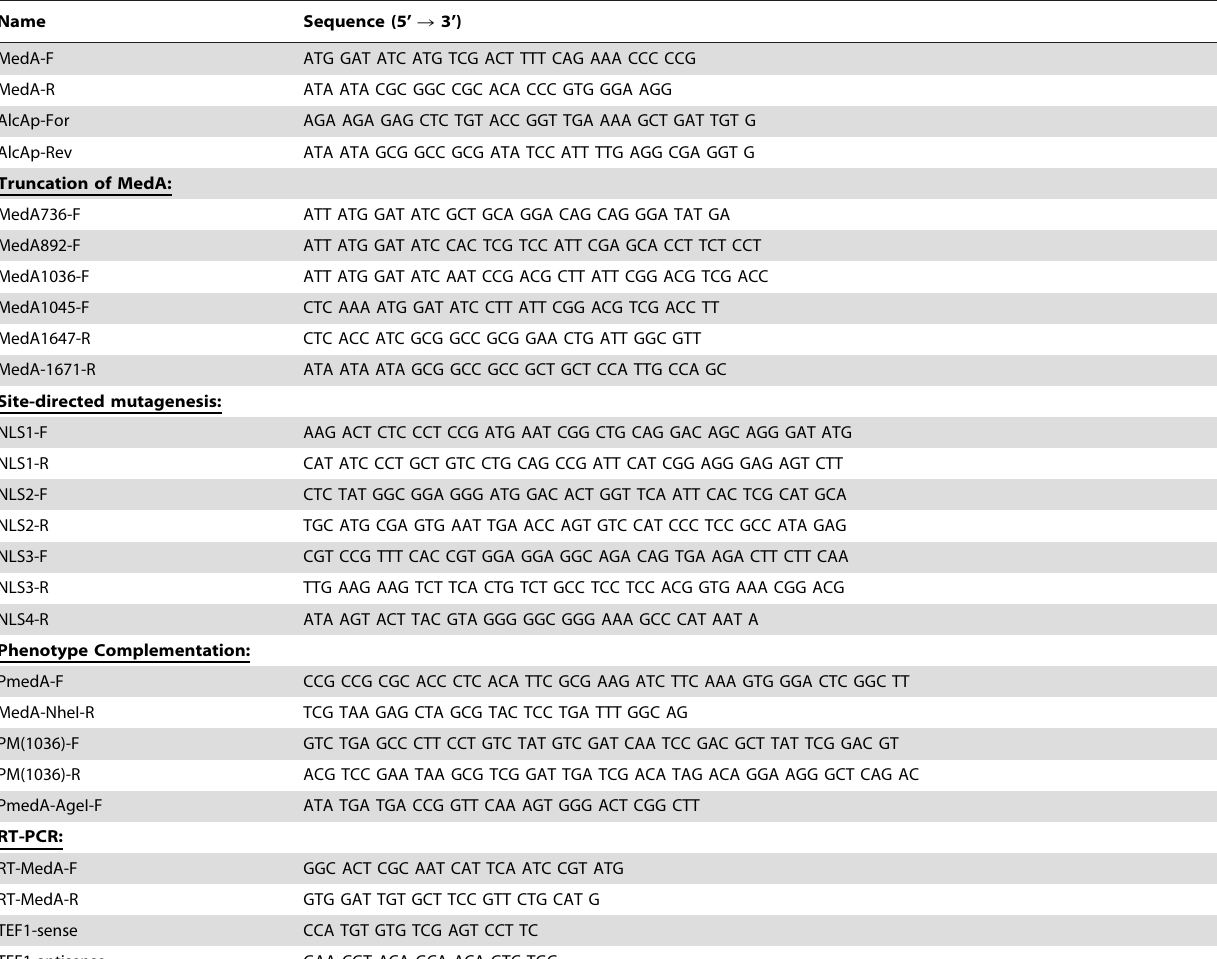
Table 1. Oligonucleotides used in this